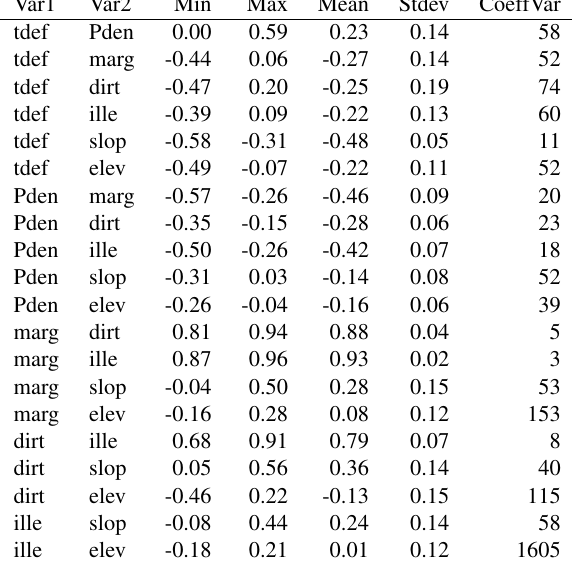
Table 4: Minimum, maximum, mean, standard deviation and co- efficient of variation of the values of the Pearson coefficient of correlation with 70 units (zoning effect)